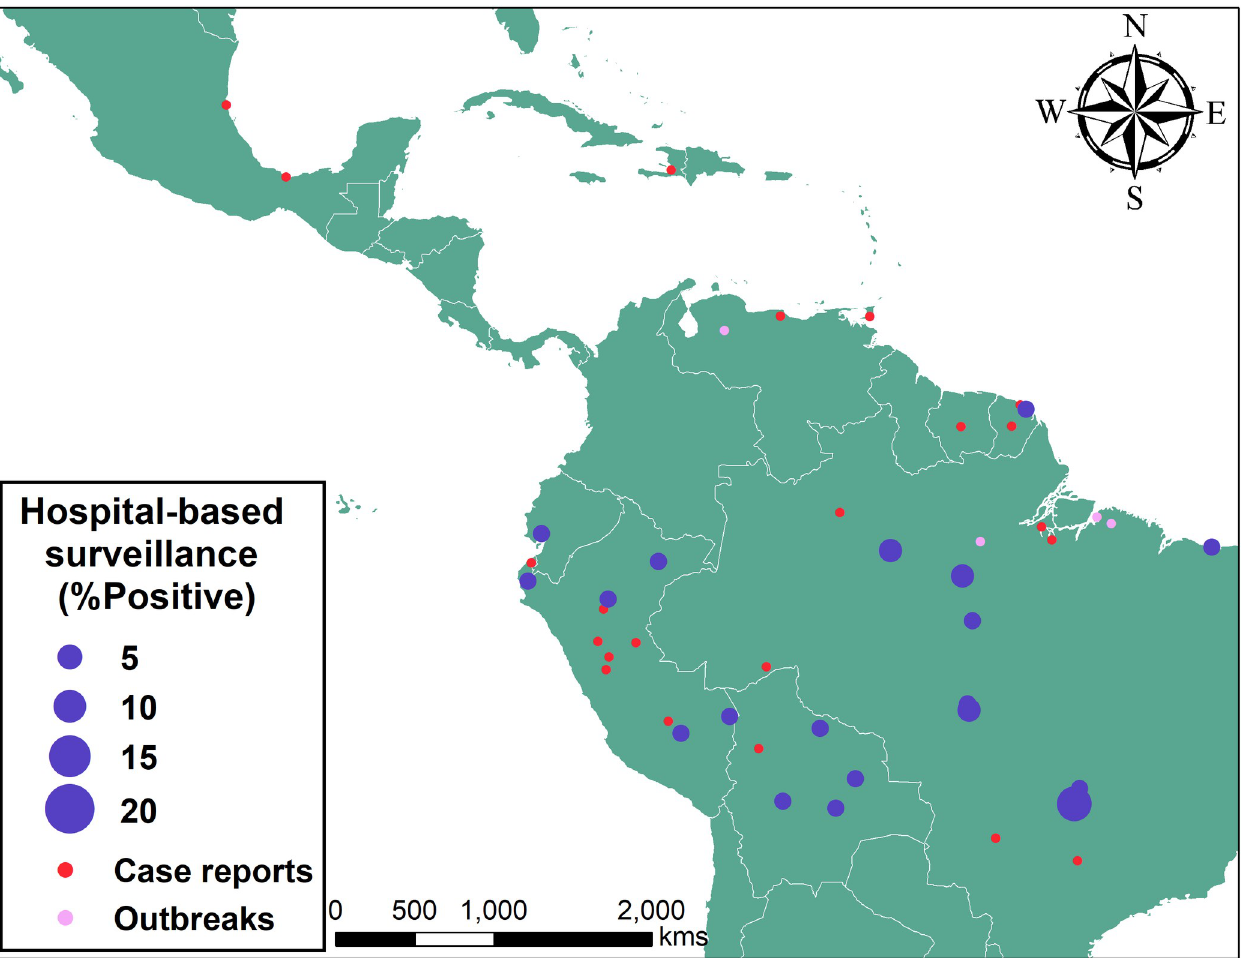
Fig 1. Map of confirmed cases of MAYV from case reports, outbreaks, and hospital-based surveillance. Map was created with ArcGIS Desktop 10.6 using shapefiles from Esri. Data sources for the shapefiles include Esri, Garmin International Inc., US Central Intelligence Agency, and National Geographic Society